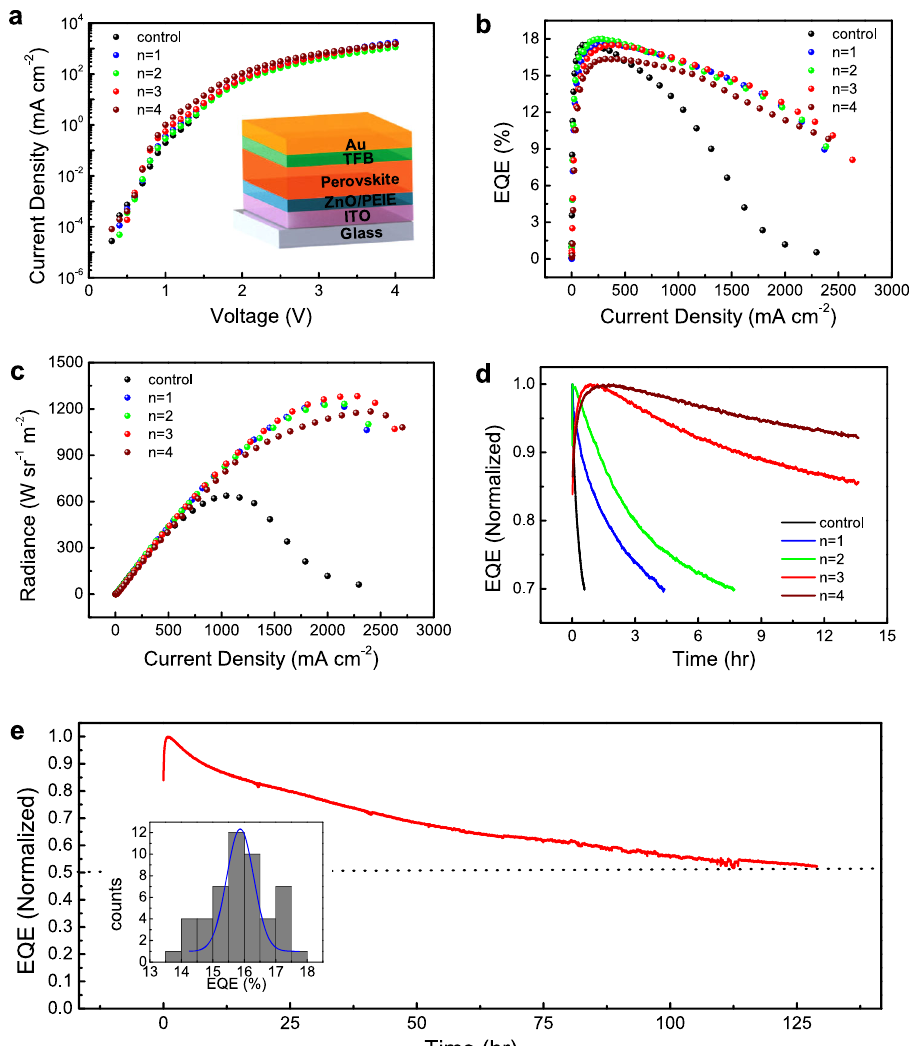
Fig. 2 PeLED performance characterizations. a J – V curves for the control and treated devices; b EQE as a function of current density for the control and treated devices; c radiance as a function of current density for the control and treated devices; d stability test under a constant bias current density of 100 mA cm − 2 for the control and treated devices; e T 50 measurement under a constant current density of 100 mA cm − 2 and histogram of peak EQE (inset) for the PPAI ( n = 3)-treated